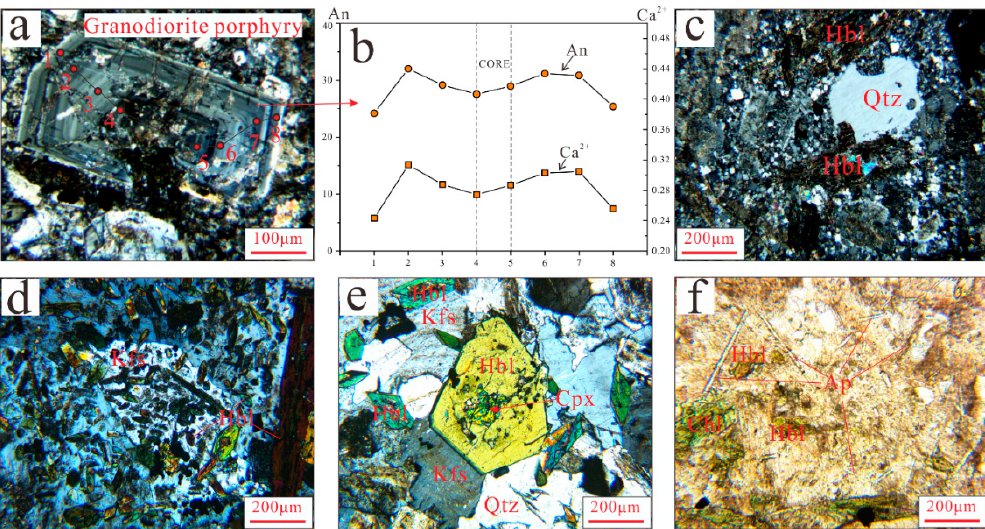
Figure 4. Representative disequilibrium textures in the Qiaomaishan intrusions. ( a ) Photomicrograph of the zoned plagioclase showing the spots of electron probe microprobe analyses (MPMA). ( b ) Profiles showing the variation of An (circles) and Ca 2+ (squares) in the zoned plagioclase. ( c ) Corrosion texture of quartz. ( d ) K-feldspar phenocryst with a microcrystalline texture. ( e ) Hornblende phenocryst with a significantly diablastic texture. ( f ) Minor acicular apatites in mafic enclaves indicating quenching. Ap—apatite; Cpx—clinopyroxene; Hbl—hornblende; Kfs—K-feldspar; Pl—plagioclase; Qtz—quartz.